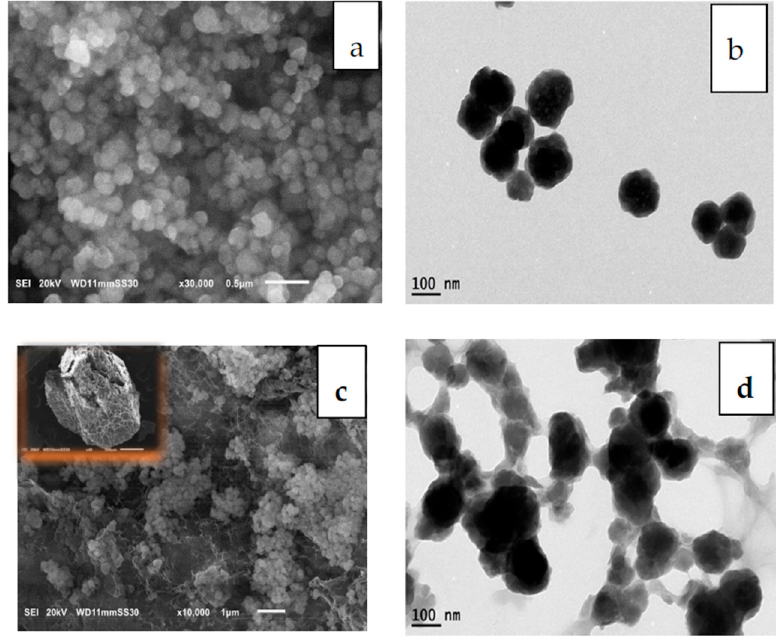
Figure 3. Morphological identification of pure MIP-202 nanoparticles and its composite. ( a ) SEM image of MIP-202 nanoparticles ( b ) TEM image of MIP-202 nanoparticles, ( c ) SEM image of